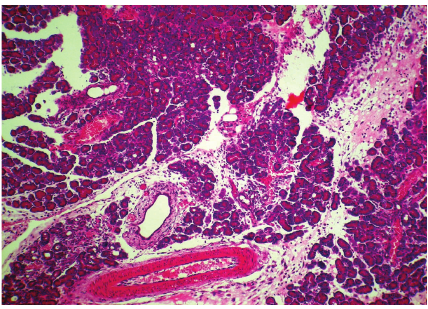
Figure 7: Histopathologic sections of pancreas (HE, x100), B: emodin group. The pancreas of emodin group showed moderate reduction in necrosis, edema, and inflammatory cells infiltration as compared with those in control group.